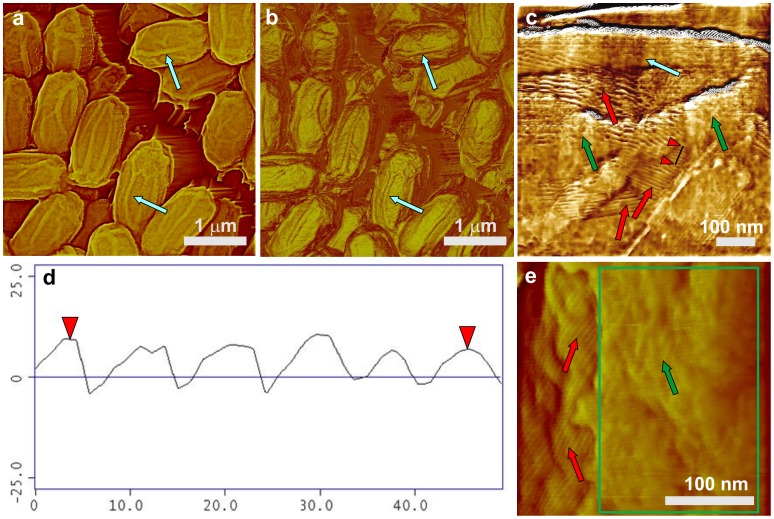
AFM images of B. subtilis wild-type spores.(a) Height and (b) phase images of spores with surface ridges (coincidental in both images) extending along the entire length of spores (several surface ridges noted by light blue arrows). (c) High-resolution height image of an area on a surface of a single spore showing surface ridges (light blue arrow), patches of an amorphous outermost layer (green arrows), and a rodlet layer (red arrows) seen beneath the amorphous layer. (d) A cross section line drawn perpendicular to rodlets (indicated with red arrows in (c)) showing a periodicity of ∼8.2 nm. (e) High-resolution height image of an area on the surface of a single spore showing patches of an amorphous outermost layer (green arrow and green rectangle), and a rodlet layer (red arrows) seen beneath the amorphous layer.